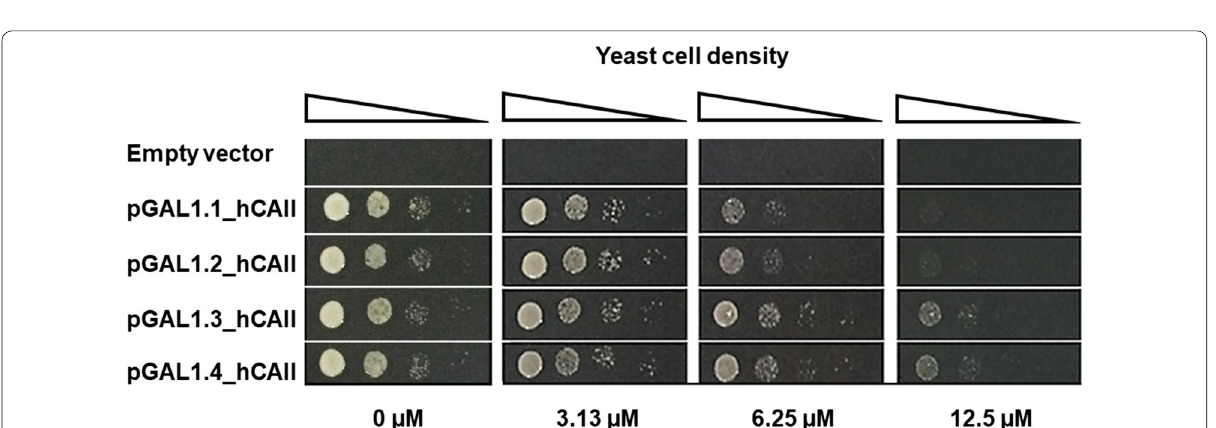
Fig. 3 Drug (AZA) sensitivity of the AS03 strain expressing varying levels of hCAII. Tenfold dilutions of cell suspension of the yeast strain AS03 carrying either the empty pRS414 vector or one of pGAL1.1_hCAII, pGAL1.2_hCAII, pGAL1.3_hCAII or pGAL1.4_hCAII at concentrations of 10 6 , 10 5 , 10 4 and 10 3 cells mL − 1 were spotted onto the surface of SG at 30 °C for 3–4 days under a low